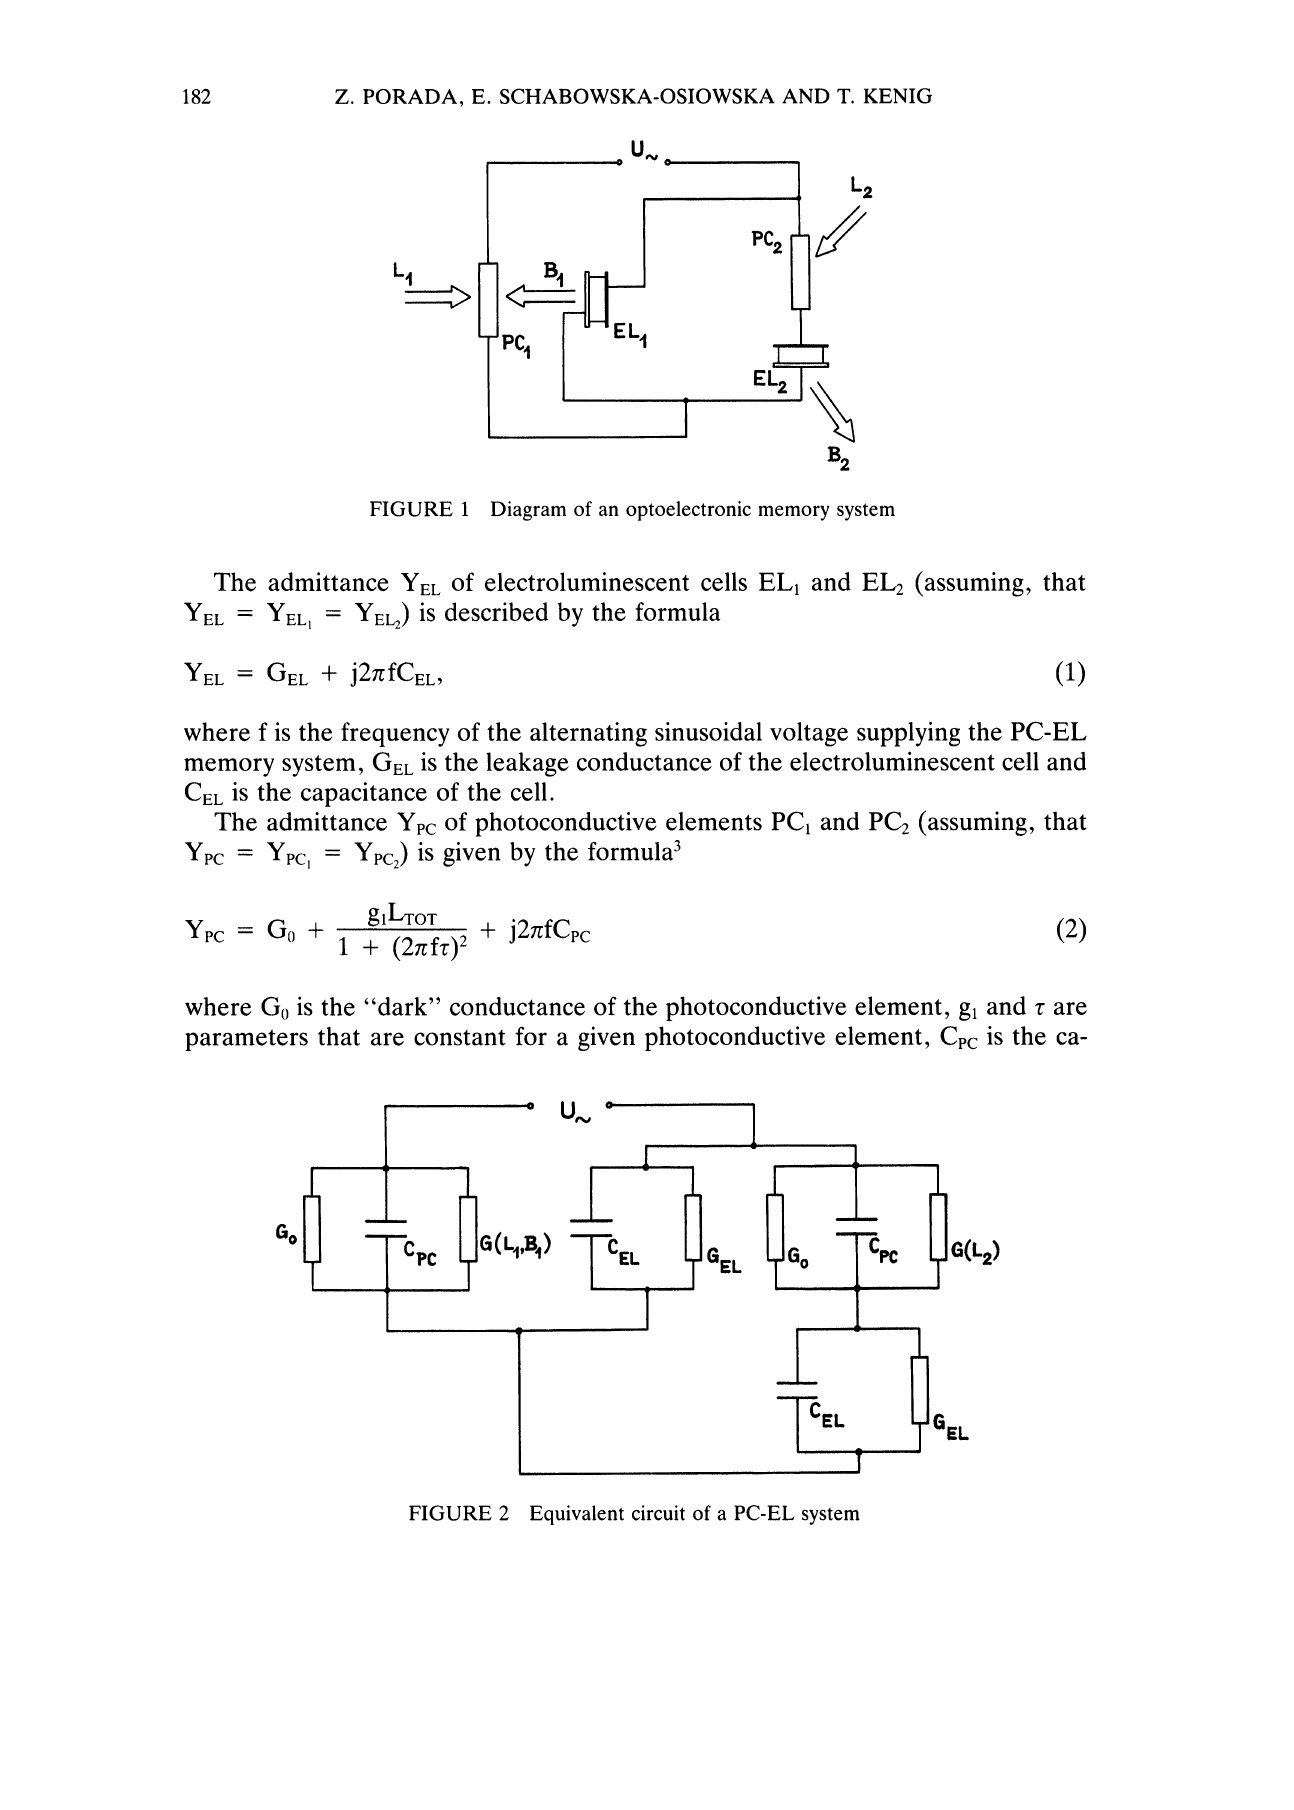
FIGURE 2 Equivalent circuit of a PC-EL